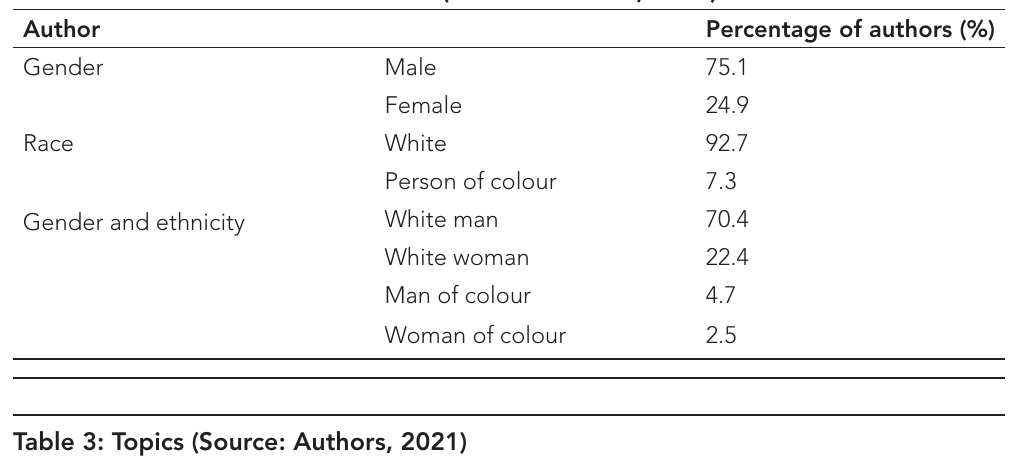
Table 2: Gender and race of authors (Source: Authors, 2021)